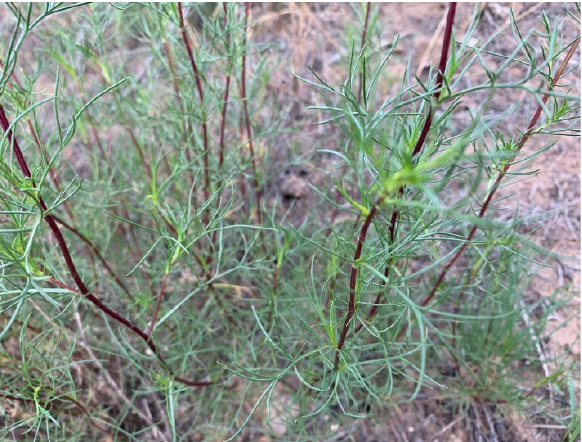
Figure 4. Photography of aerial parts of wild Artemisia ordosica collected at the vegetative